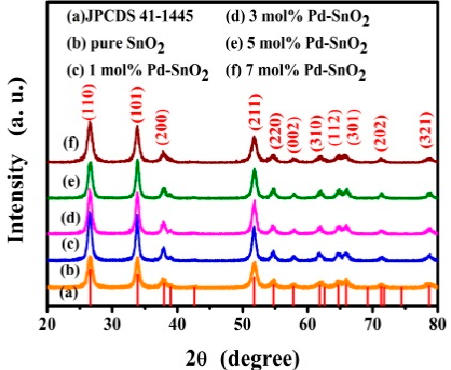
Figure 1. XRD patterns of as-prepared samples with different Pd contents.